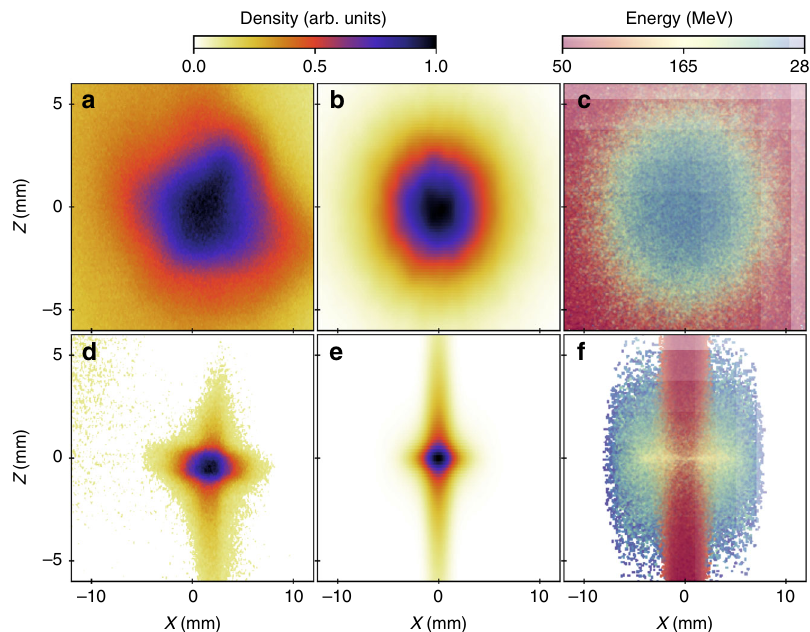
Fig. 3 Electron beam transverse pro fi les observed on the fi rst LANEX screen. Measured transverse pro fi le without ( a ) and with ( d ) permanent magnet quadrupoles of variable strength (QUAPEVA). b , e Associated numerical simulations (see Methods section) of the transverse pro fi le assuming a broadband energy spectrum spanning from 50 to 280 MeV and using the measured divergences and a screen resolution of 150 μ m and simulated electron energy distribution in the transverse plane ( c , f